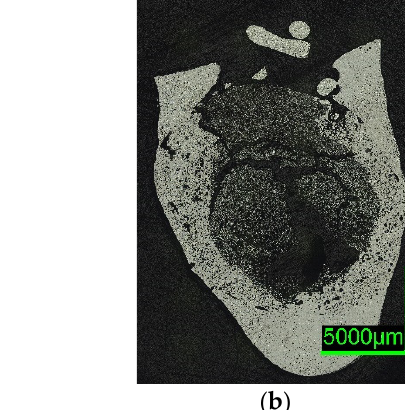
( b ) Figure 8. Digital microscope images of ( a ) 0%C-SAF-2; ( b ) 0%C-EAF-2, dipped into EAF/SAF slag. Comparing the samples immersed in slag, shown in Figures 8 and 10, the results are consistent with the photographs in Figures 2b,c and 5b,c. A slag layer coated the DRI sur- faces; the absence of bubbles indicated that no reactions occurred when carbon-free DRI was immersed. On the other hand, carburized DRI formed a less adherent slag layer with the iron oxide-free SAF slag and was highly reactive with the iron oxide-containing EAF slag. The former phenomenon could be explained by the poor adhesion of the glassy slag layer. The latter was due to the rough surface of C800-EAF, visible in both the photograph and the digital microscope image in Figures 5 and 10. Tables 6 and 7 reports the slag com- position before and after the experiments.